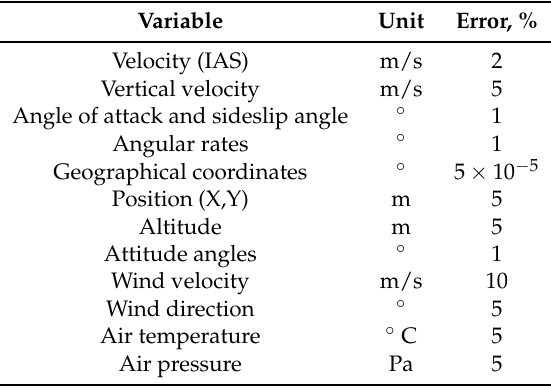
Table 3. Typical measurement errors in of nominal values